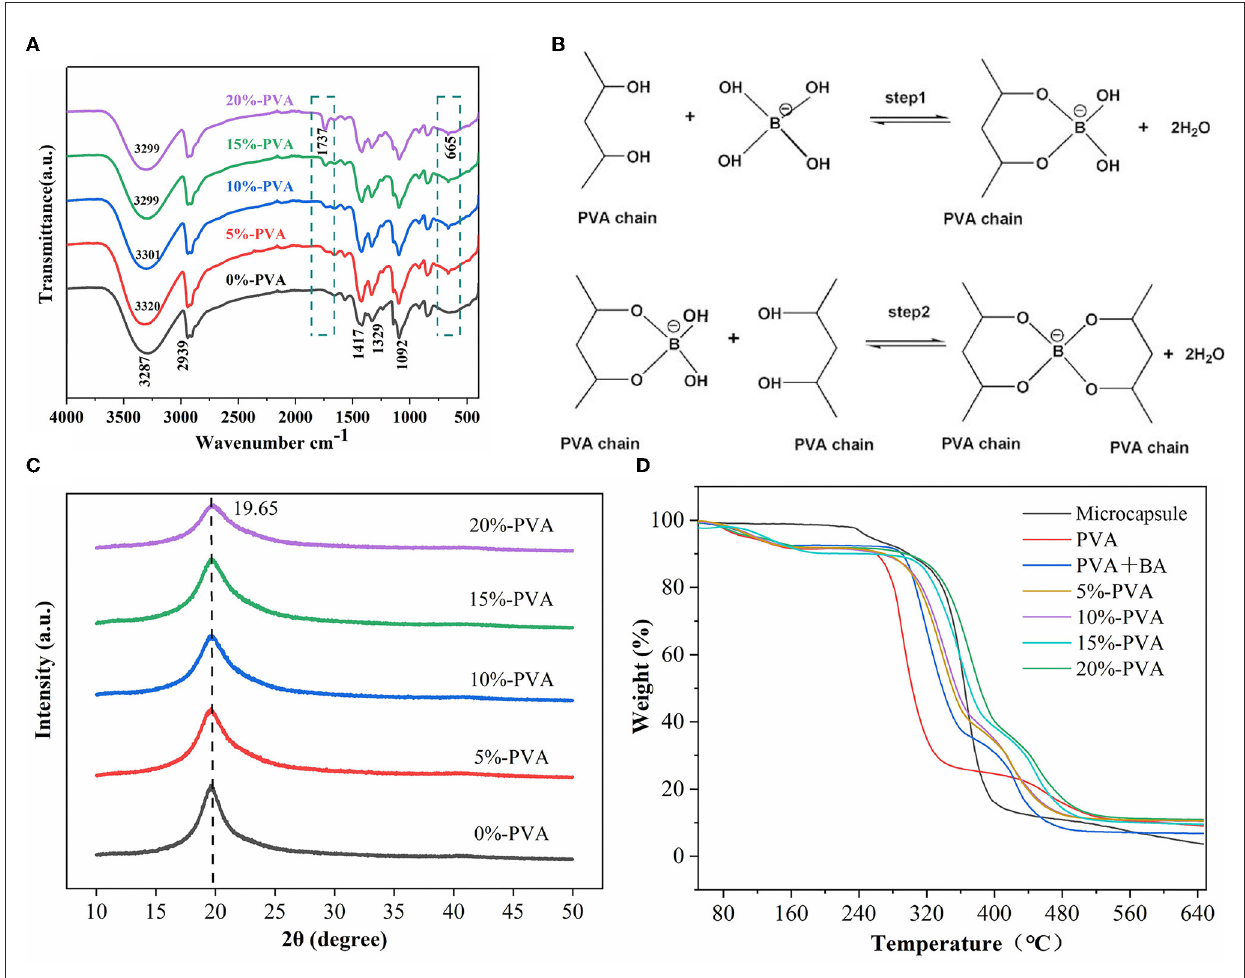
FIGURE2 Infrared spectra of PVA films with different microcapsule contents (A) , mechanism of cross-linking reaction between PVA and borate ion (B) , scanning electron microscopy (XRD) patterns of PVA films with different microcapsule contents (C) , and thermal properties of the antibacterial film (D) . PVA, polyvinyl alcohol.